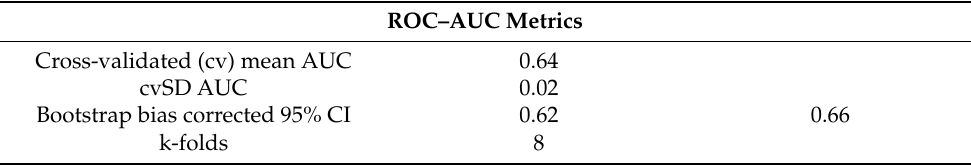
Table 2. ROC–AUC cross-validated results for the study area (AMA). ROC–AUC Metrics